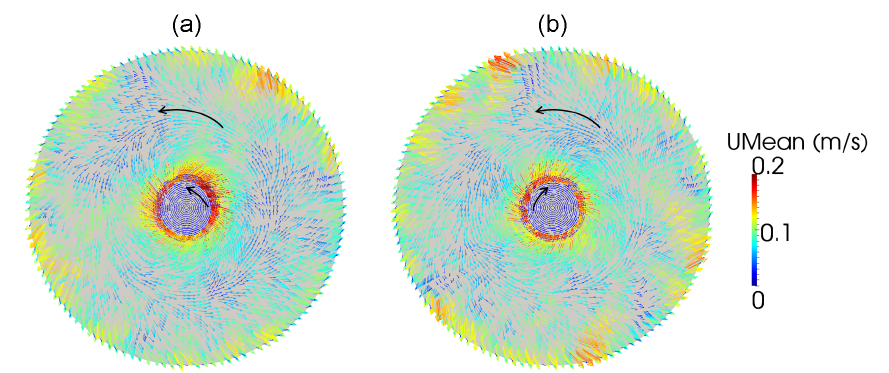
Figure 9. Time-averaged flow velocity vectors in the upper plane of the melt: ( a ) RMF and seed rotation are in the same direction (Case 7), ( b ) RMF and seed rotation are in the opposite direction (Case 8).